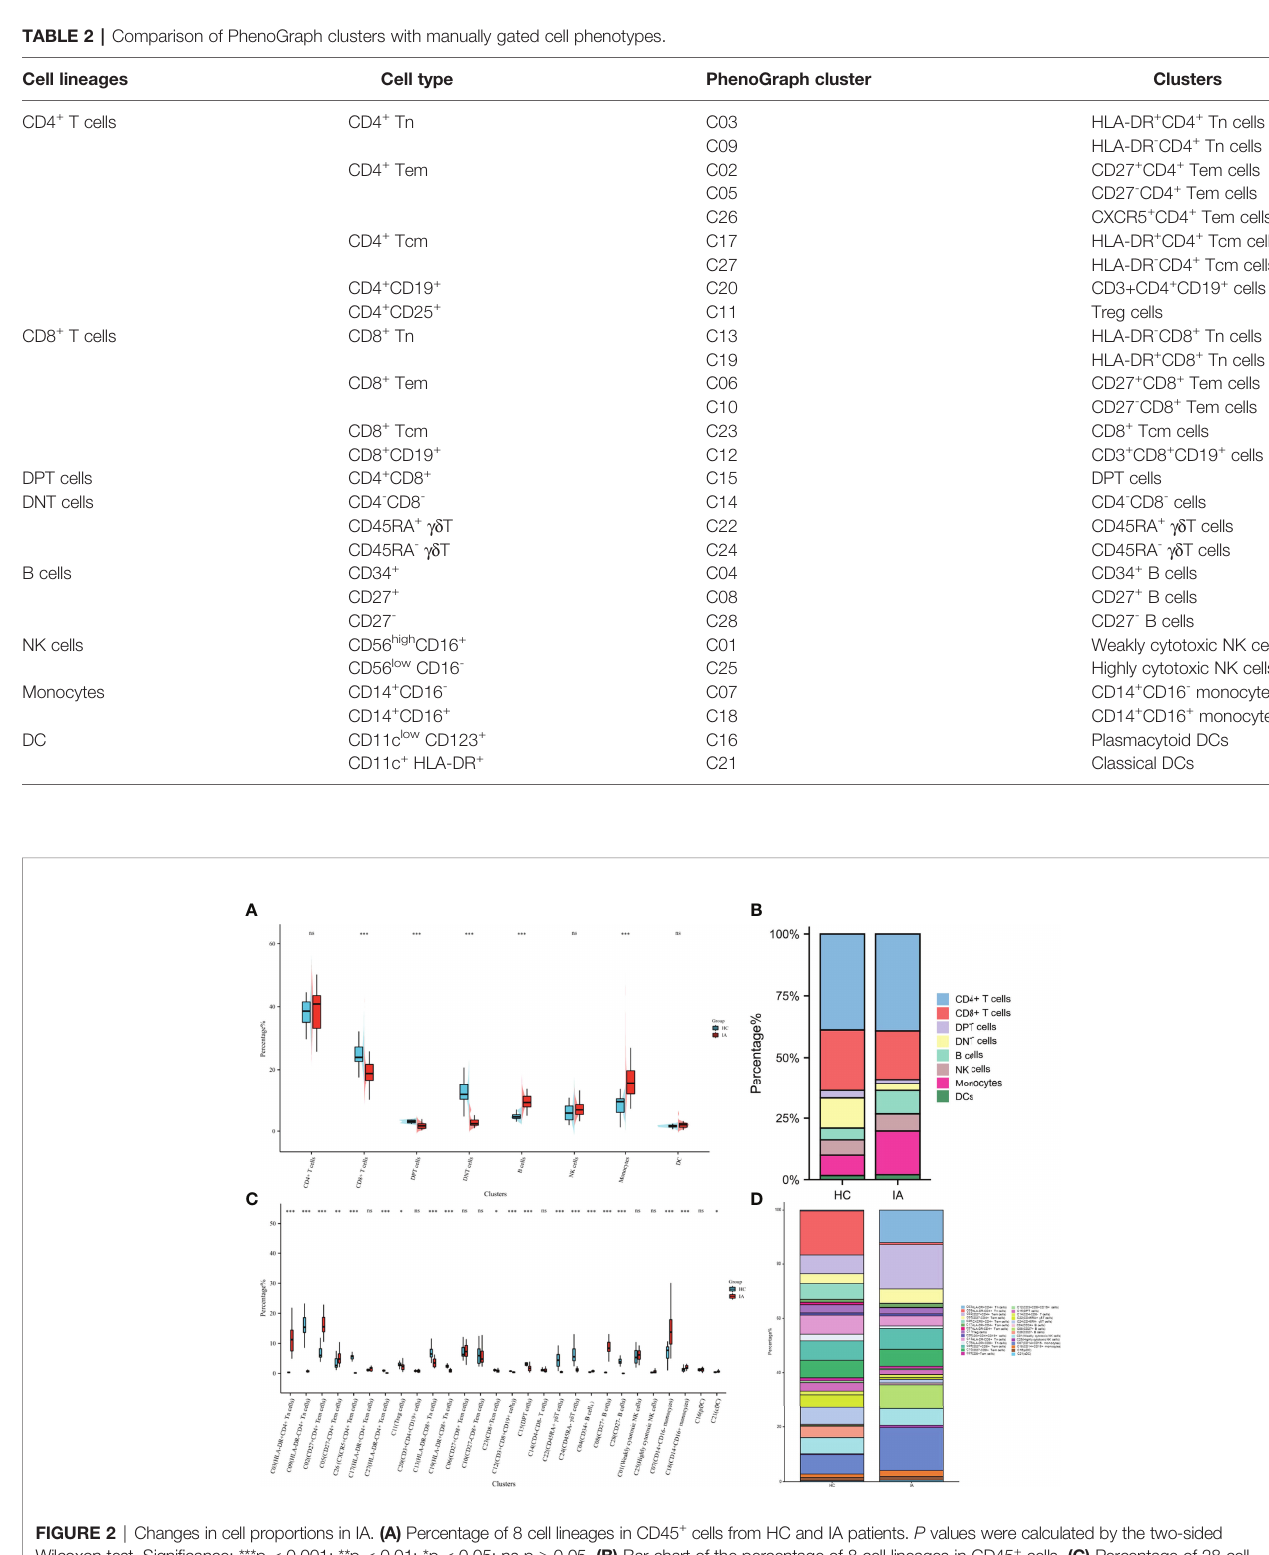
FIGURE 2 | Changes in cell proportions in IA. (A) Percentage of 8 cell lineages in CD45 + cells from HC and IA patients. P values were calculated by the two-sided Wilcoxon test. Signi fi cance: ***p < 0.001; **p < 0.01; *p < 0.05; ns p ≥ 0.05. (B) Bar chart of the percentage of 8 cell lineages in CD45 + cells. (C) Percentage of 28 cell lineages in CD45+ cells from HC and IA patients. P values were calculated by the two-sided Wilcoxon test. Signi fi cance: ***p < 0.001; **p < 0.01; *p < 0.05; ns p ≥ 0.05. (D) Bar chart of the percentage of 28 cell lineages in CD45 +